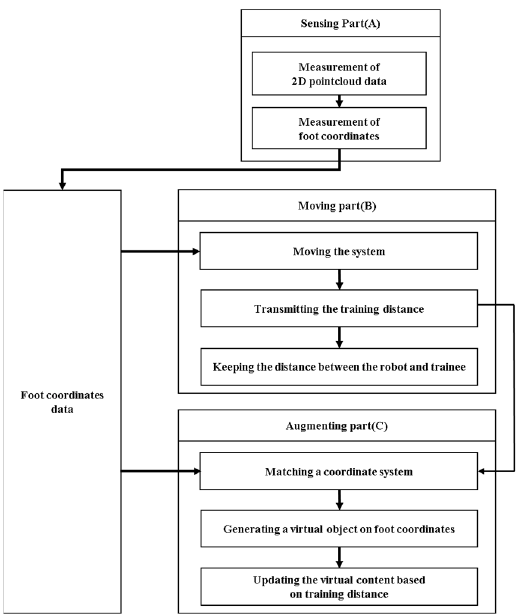
Figure 2. Proposed system’s block diagram.